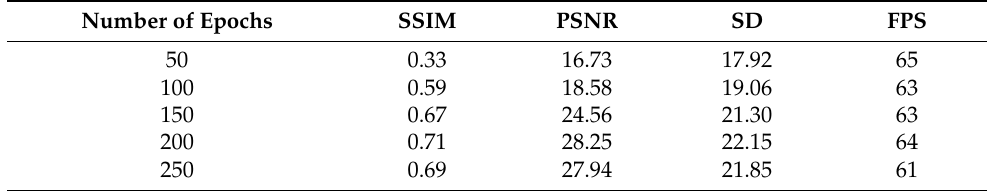
Table 9. The effect of different epoch numbers on the experimental